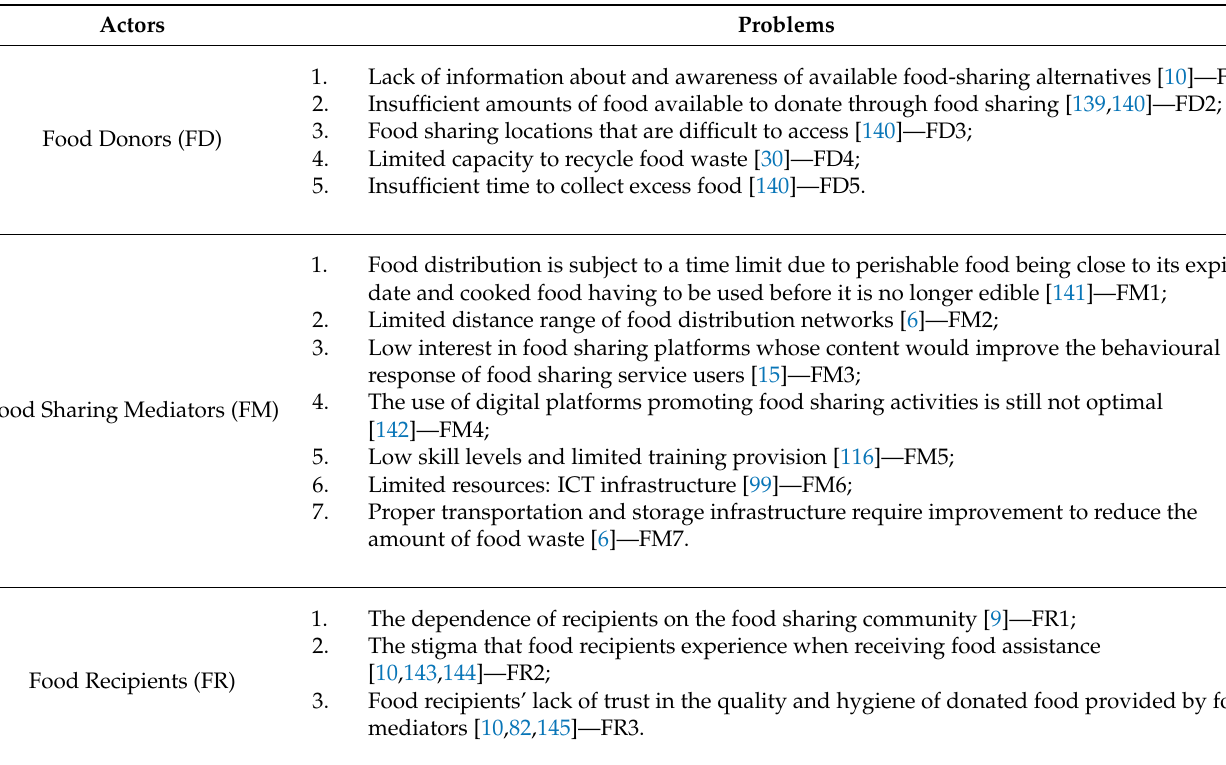
Table 3. Problems